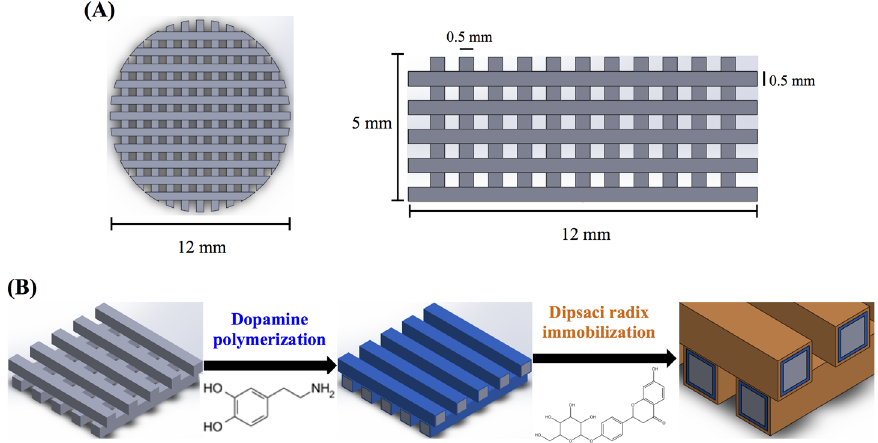
Figure 1. The ( A ) top view and side view of 3D printed poly(lactic acid) (PLA) scaffold; ( B ) Schematic illustration of dopamine-assisted immobilization of XD on